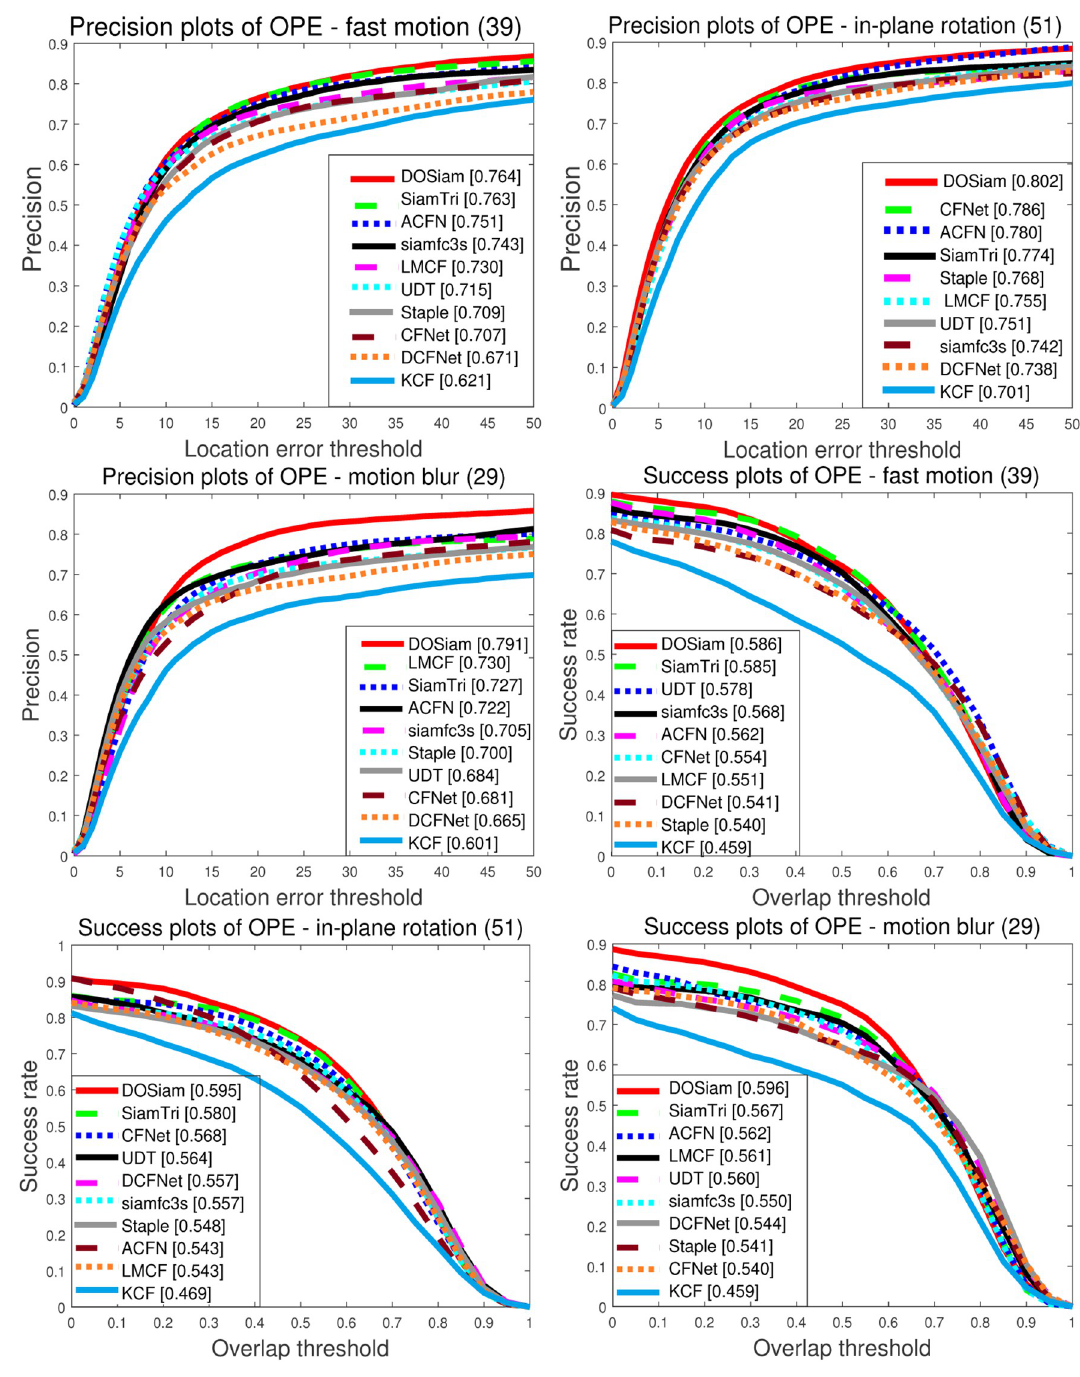
Fig 6. Precision and success plots of OPE. Our tracker has good tracking performance in challenge environments fast motion, in- plane rotation, motion blur and the success rate and precision rate in these challenge environments are OTB2015 benchmark tested.